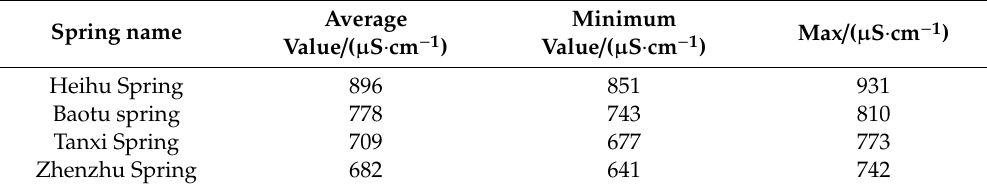
Table 1. Characteristic values of the EC of spring water.